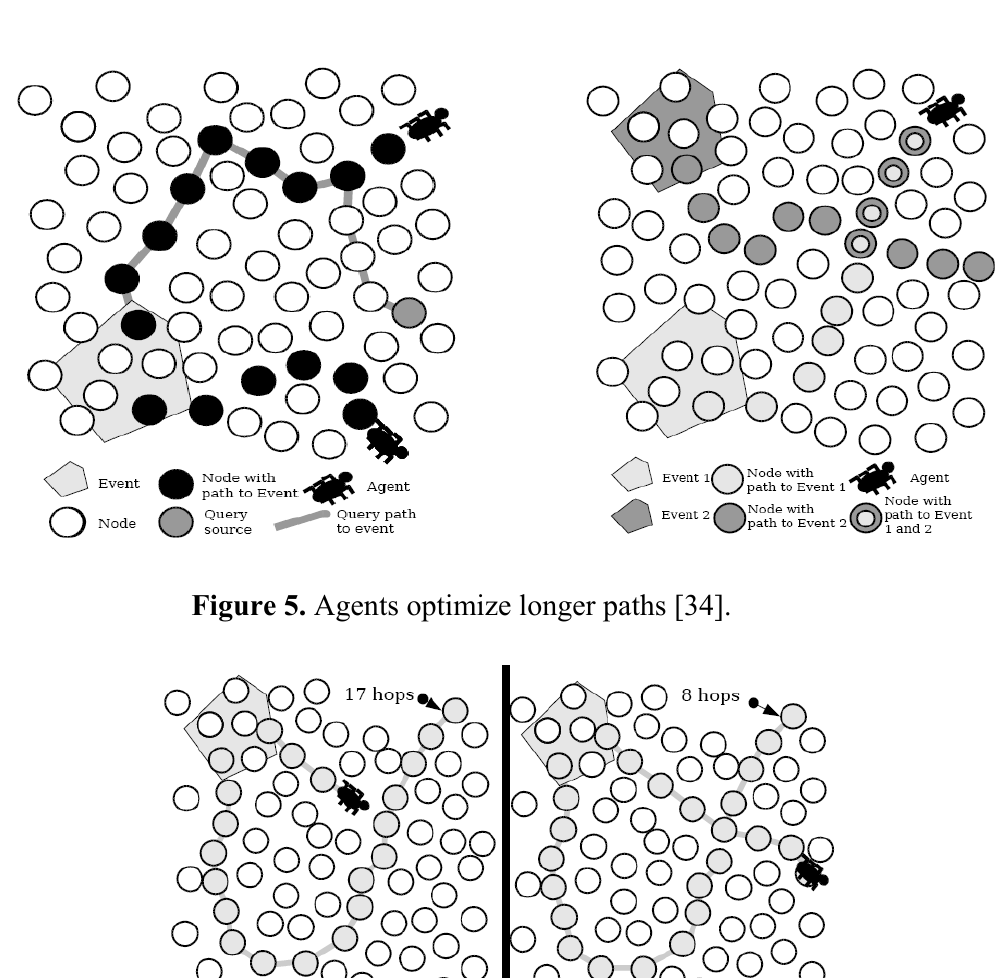
Figure 3. Event agent [34]. Figure 4. Agents aggregate paths [34].